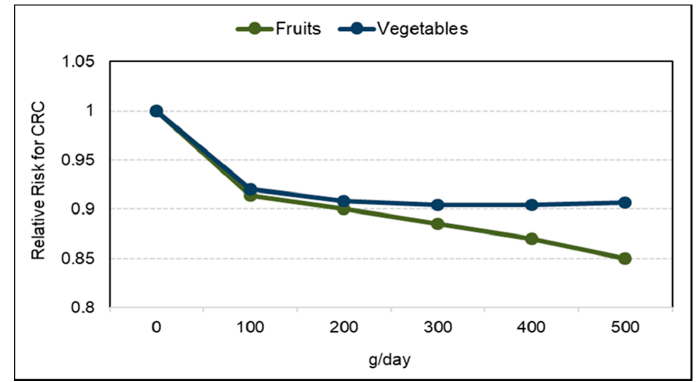
Figure 18. Non-linear dose-response effect of increasing intake of fruits and vegetables on colorectal cancer (CRC) risk from meta-analysis of cohort studies [260].